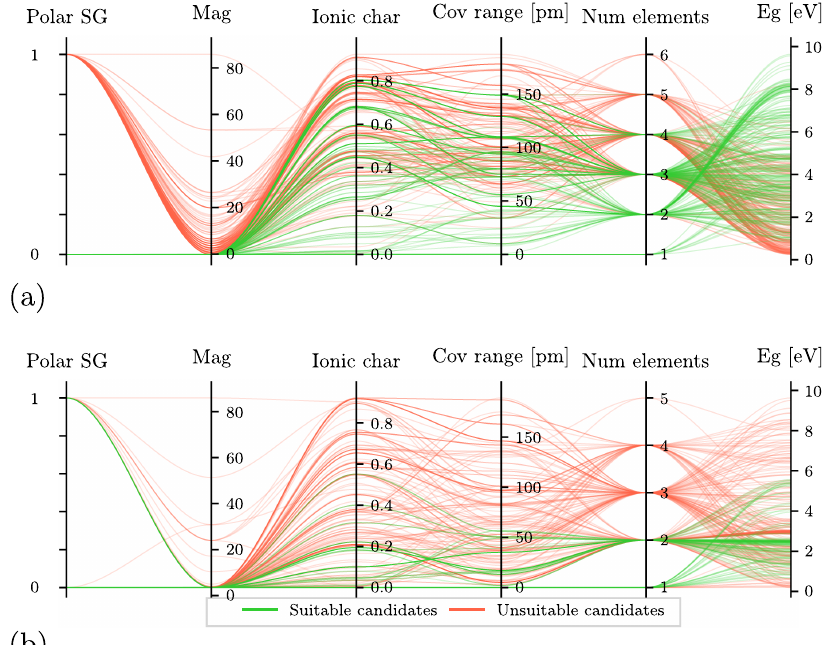
Fig. 3 Parallel coordinate plots. Parallel coordinate plots for the ( a ) criteria-based and ( b ) empirical approaches. To limit data cluttering up to 250 entries for each class were randomly collected. The axes show total magnetization (mag), space group (SG), ionic character (ionic char), covalent range (cov range) as calculated from elemental properties, number of elements (num elements) and energy gap (Eg) as extracted from the MP